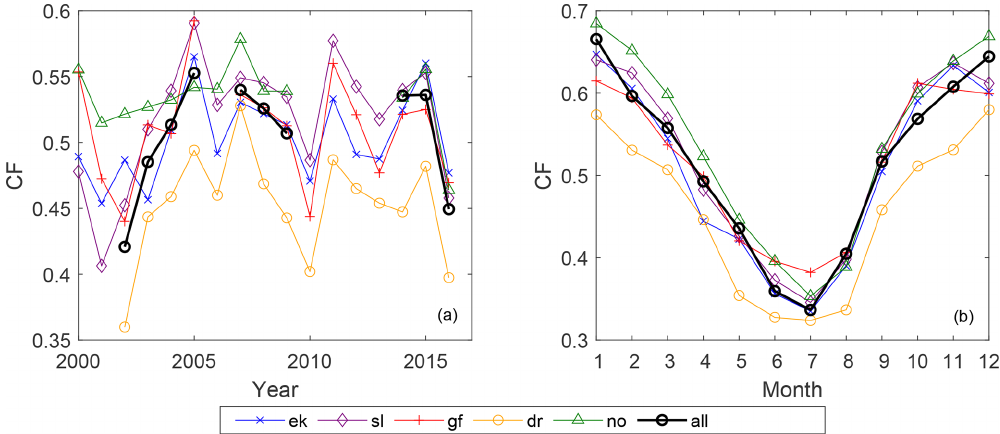
Figure 3. (a) Interannual variation in the capacity factor (CF) for the five sites and the total interconnected system (“all”). If more than half of the data in 1 year were missing, the value for that year was excluded in the plot. (b) The seasonal variation in CF for the five sites and the interconnected system (“all”).